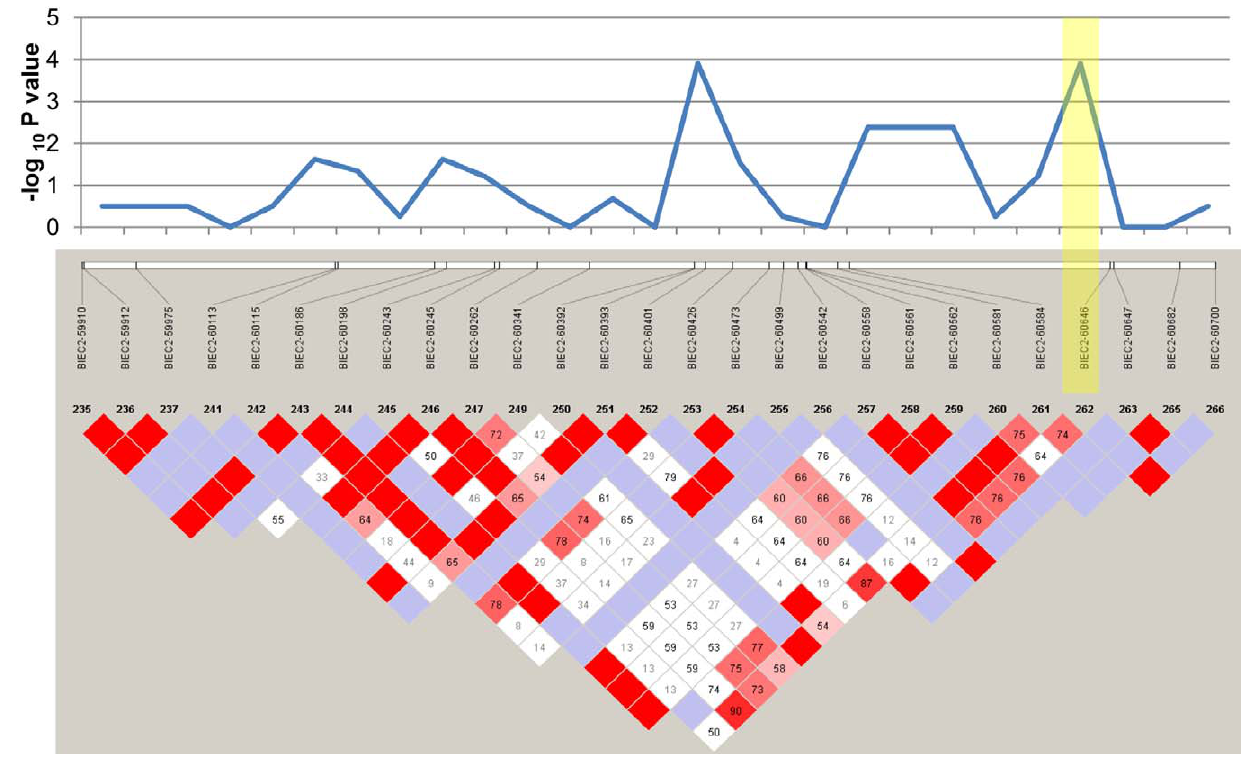
Figure 3. Linkage disequilibrium plot of the homozygous region associated with LFS. Plotted at the top are the corresponding p-values for these 27 SNPs. The yellow shaded box highlights the SNP closest to MYO5A . Red diamonds represent D’ values equal to 1, lower values of D’ are given in within the boxes in shades of pink to white, while non-significant associations are blue.